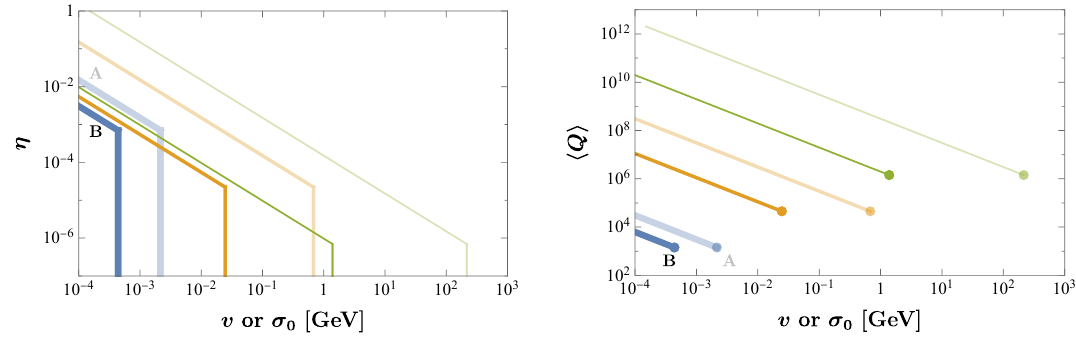
Figure 7 . Similar to figure 6, but for an SOPT. Here, T G = λ − 1 / 2 v , p in = 1 , and p false /p true = e − 2 . φ The two models considered are m Q = 5 . 15 λ 1 / 4 σ 0 Q 3 / 4 (A, lighter shading) and m Q = ( λ φ λ S ) 1 / 4 Qv φ with λ S = 0 . 2 (B, darker shading). Note that here Model A and B share the same λ φ . The curves correspond to the values λ φ = 10 − 2 (blue thick), 10 − 3 (yellow medium), and 10 − 4 (green thin). Curves with λ φ & 10 − 1 would require T G , m S < MeV, which is disallowed by the constraints on radiation degrees of freedom during Big Bang